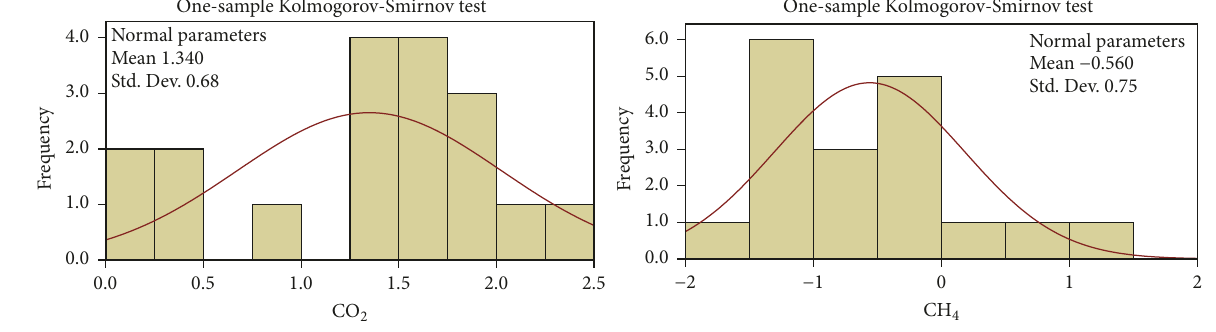
Figure 3: The normal distribution test of lg CO 2 and lgCH 4 .